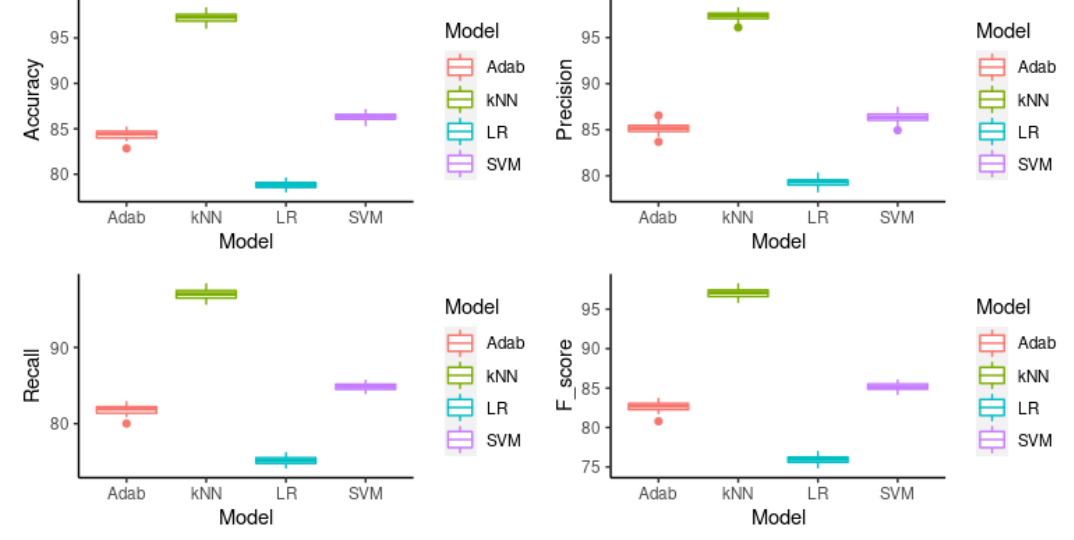
Figure 2. Accuracy , precision , recall , and f -Score resulting from 10-fold CV